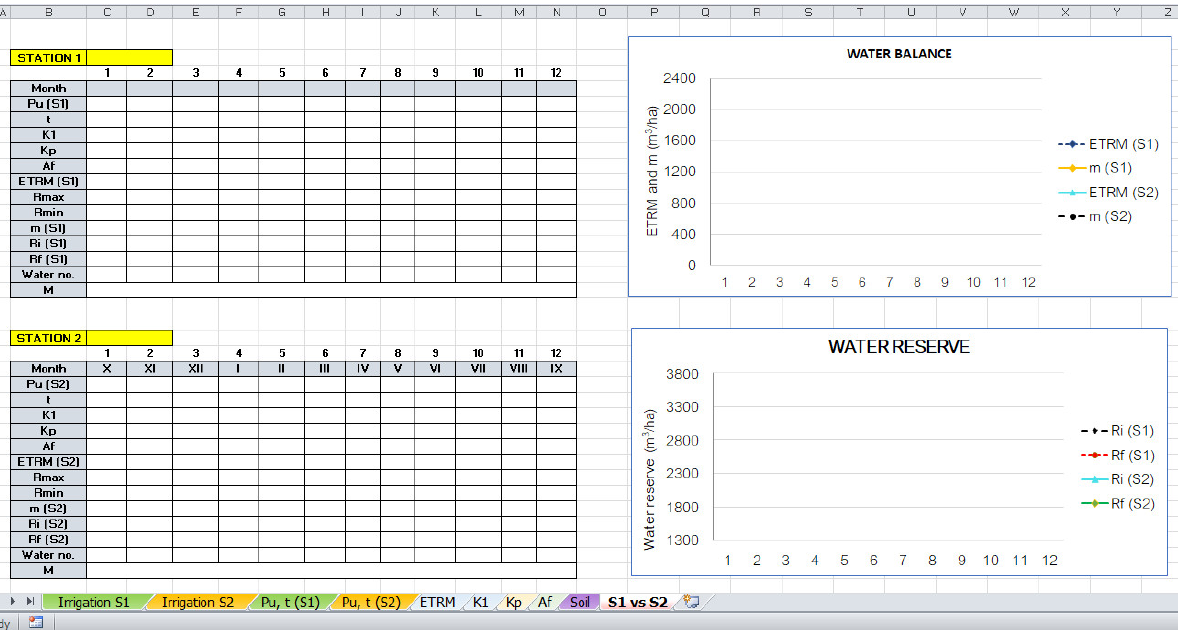
Figure 11. The “S1 vs. S2” worksheet.